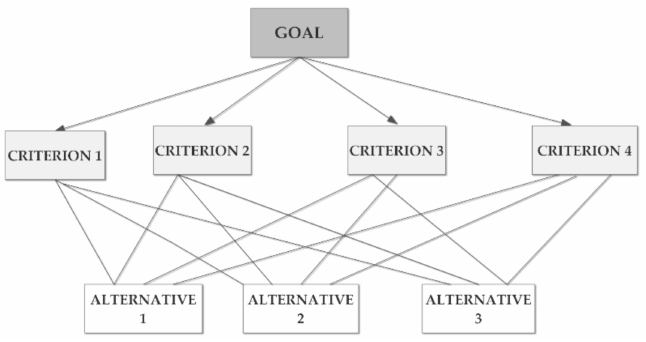
Figure 2. Example of a hierarchy of criteria in AHP